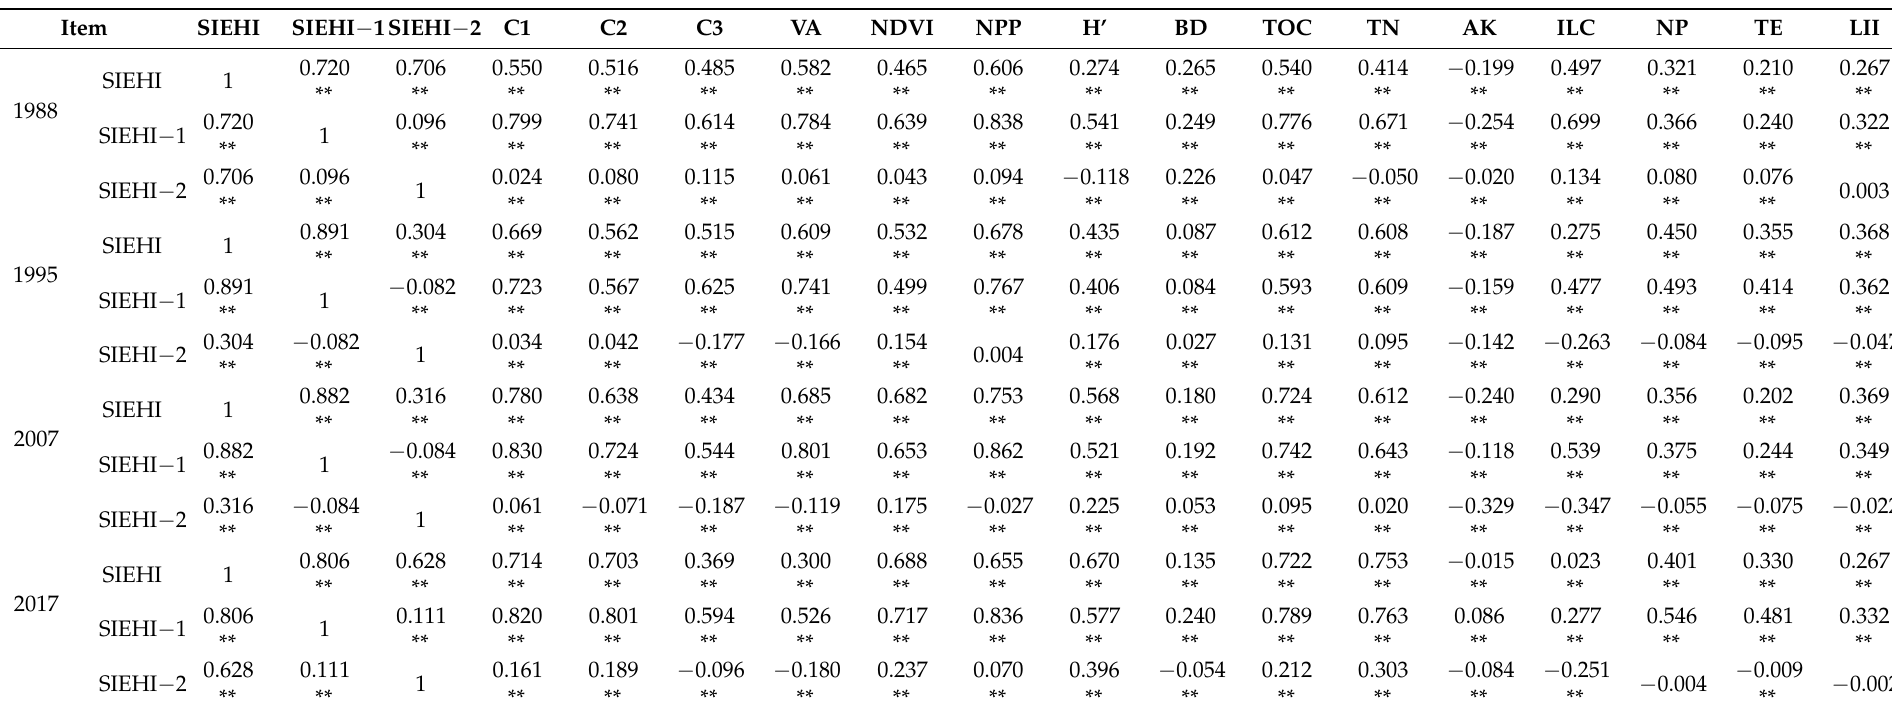
Table 5. Correlation coefficients of the sandy island ecosystem health with different components and factors in the four